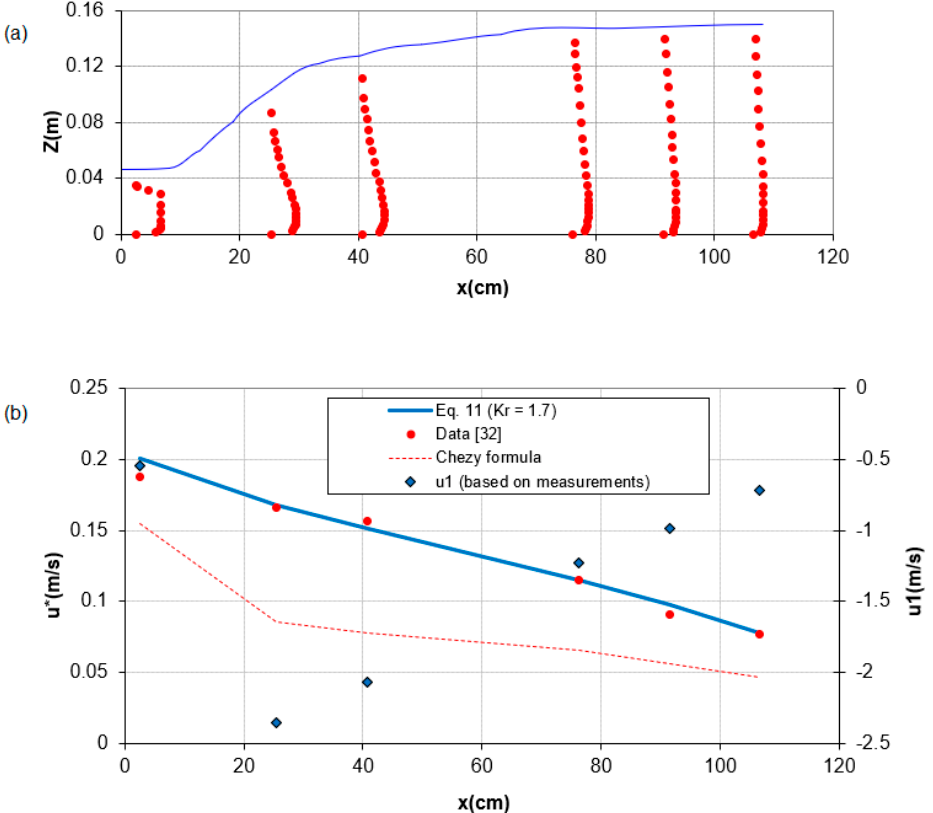
Figure 10. Water flow expanding downstream of a jet outlet: ( a ) horizontal downstream velocity measurements and ( b ) spatial variations of u 1 and shear velocity.